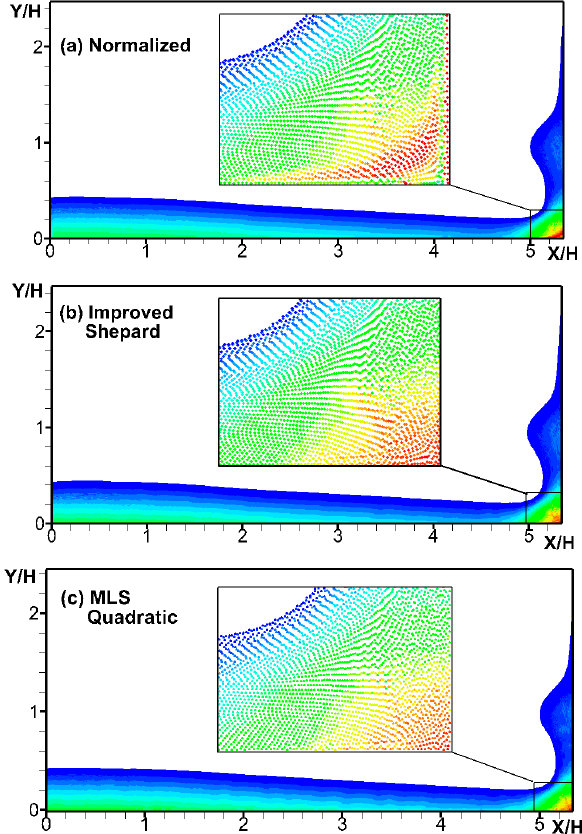
Figure 8. An example of corner point pressure distribution. Comparison between the ( a ) normalized method, ( b ) improved Shepard, and ( c ) MLS method (quadratic based).